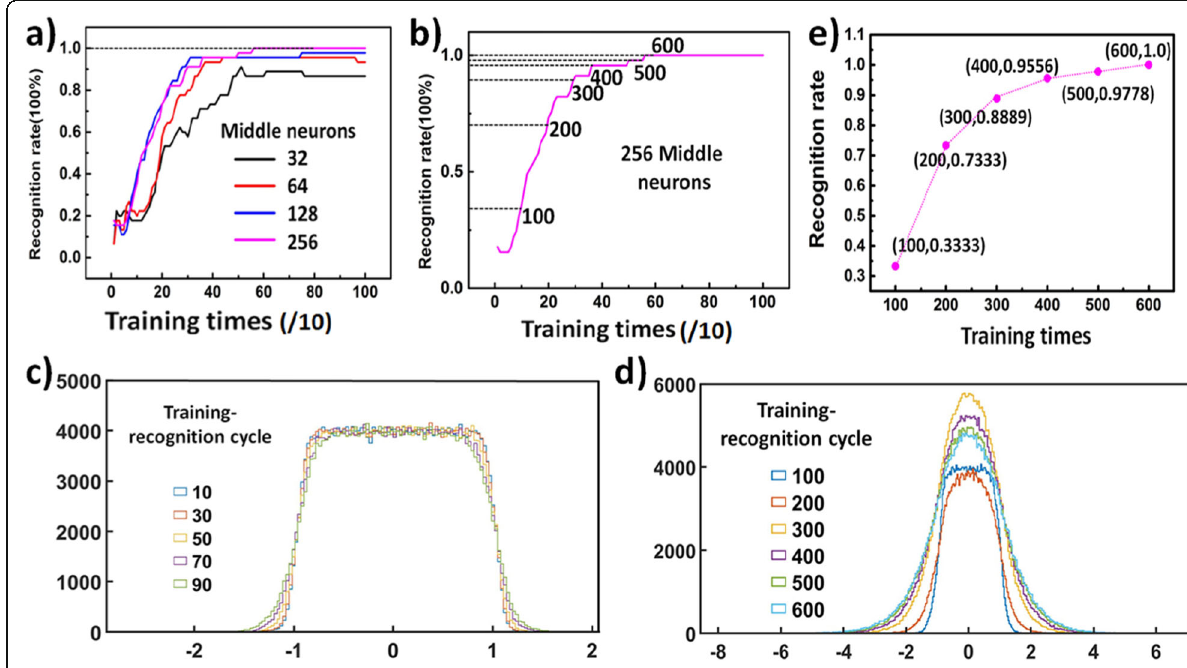
Fig. 5 Realization of the face recognition. a Recognition rate curve at different numbers of hidden neurons (32, 64, 128, and 256). b Recognition rate curve at 256 hidden neurons; the recognition rate reaches 100% after nearly 600 training-testing epochs. c The distribution of weight values after 10 to 90 (in steps of 20) training epochs. d The distribution of weight values after 100 to 600 (in steps of 100) training epochs. e Recognition rate after the replacement; the weight values were replaced after 100~500 training epochs (in steps of